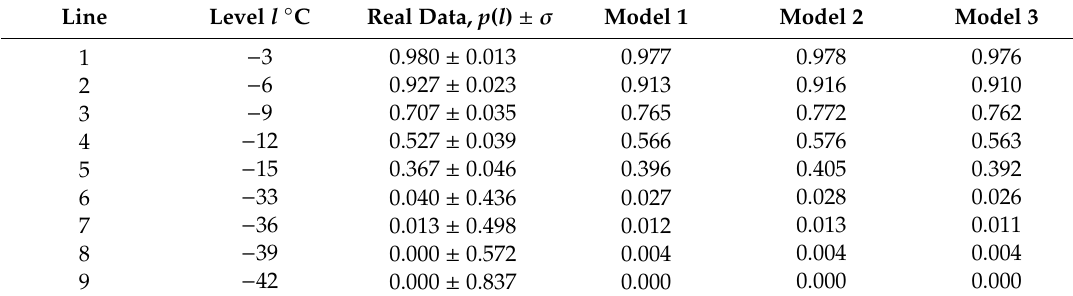
Table 3. Probability p ( l ) , Area 1, 5 December.